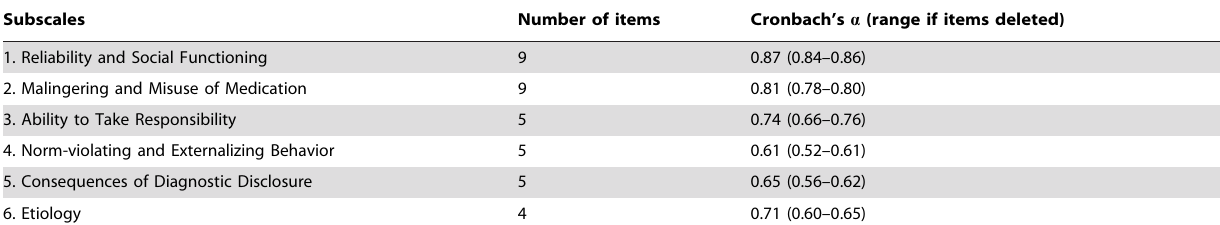
Table 4. Internal Consistency Scales.